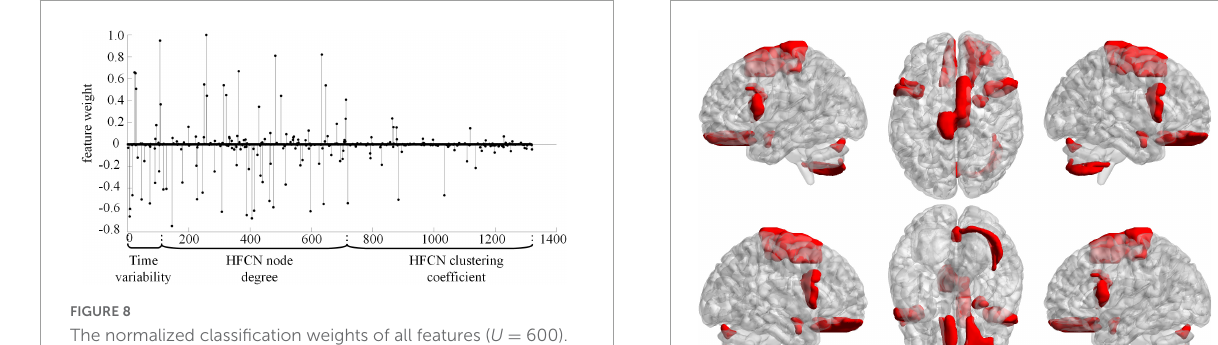
the FC series decreases, which may lead to a decrease in the reliability of HFCN. The choice of cluster number U also has a greater impact on the classification results. As shown in Figure 5B , the impact of U on performance is analyzed by fixing the number of clusters U to be one of {300, 400, 500, 600, 700, 800}. It can be seen that ACC is more sensitive to changes in the number of clusters, and the highest ACC can be obtained when U is